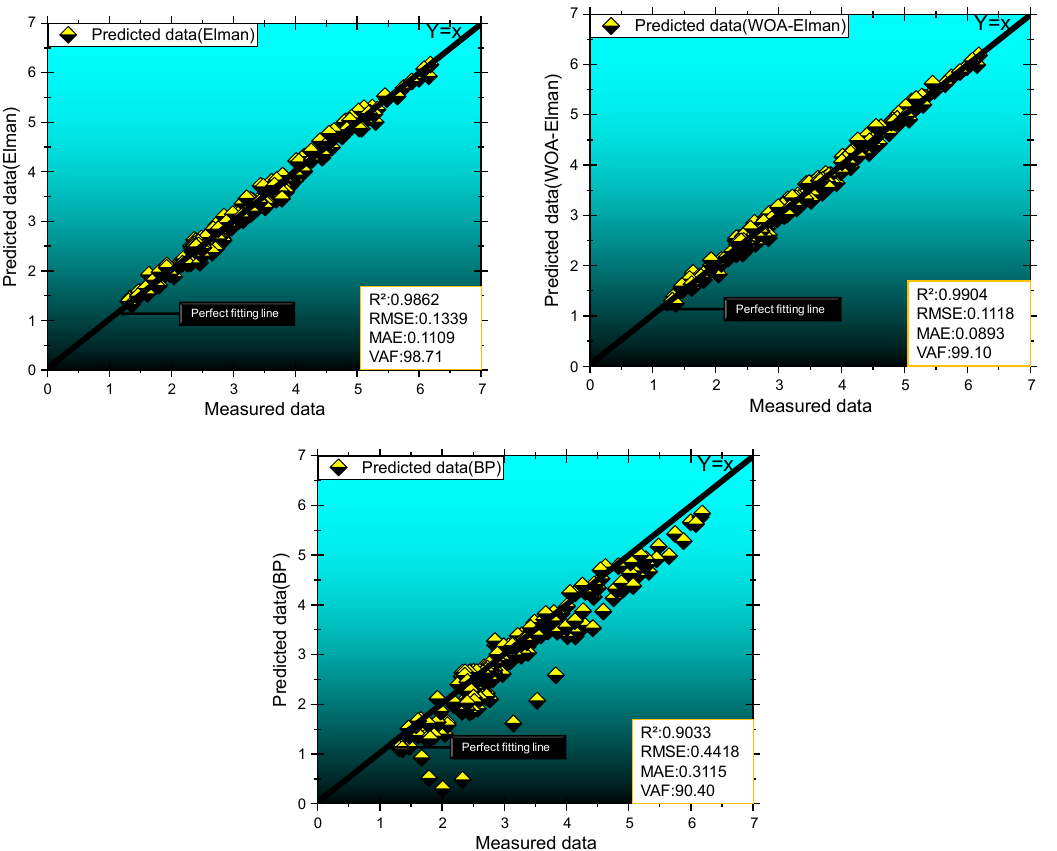
Figure 6. Correlation and error analysis between predicted value and real value of three machine learning models based on training set.